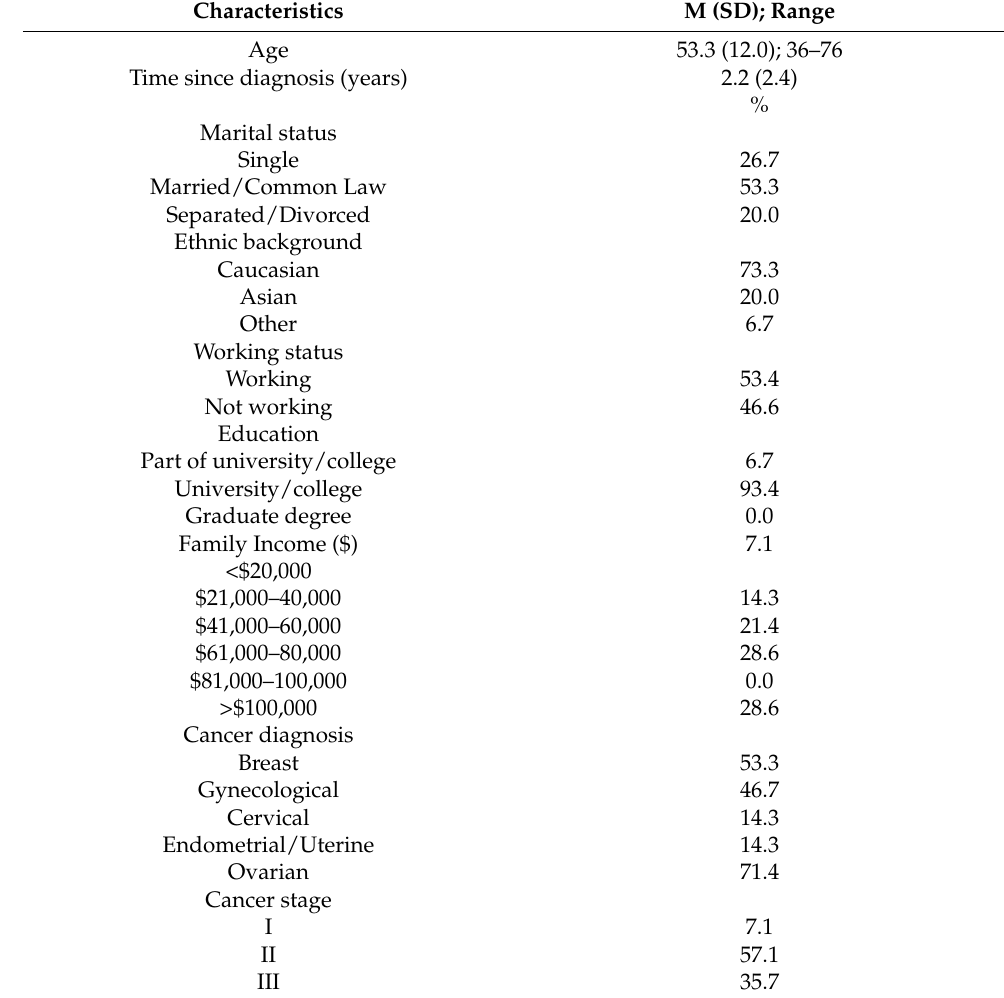
Table 1. Demographic and medical characteristics of the participants ( n =